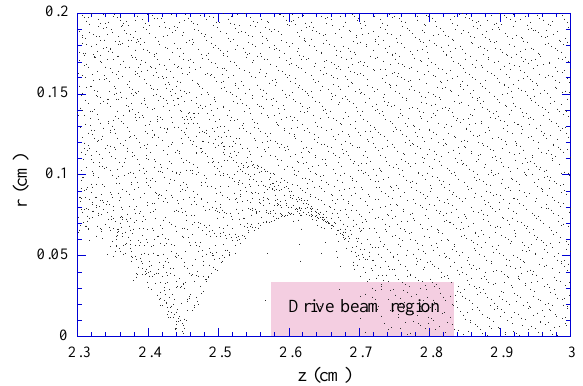
FIG. 1. (Color) Particle-in-cell code (Barov [6]) simulation of blowout regime, with beam density much larger than plasma